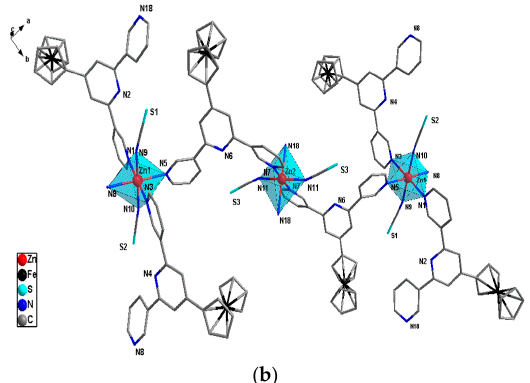
Figure 6. The asymmetric unit ( a ) and coordination environment of the Zn II ion ( b ) in complex 4 with atom part numbering and ring labeling (H atoms and solvent molecules are omitted for clarity).